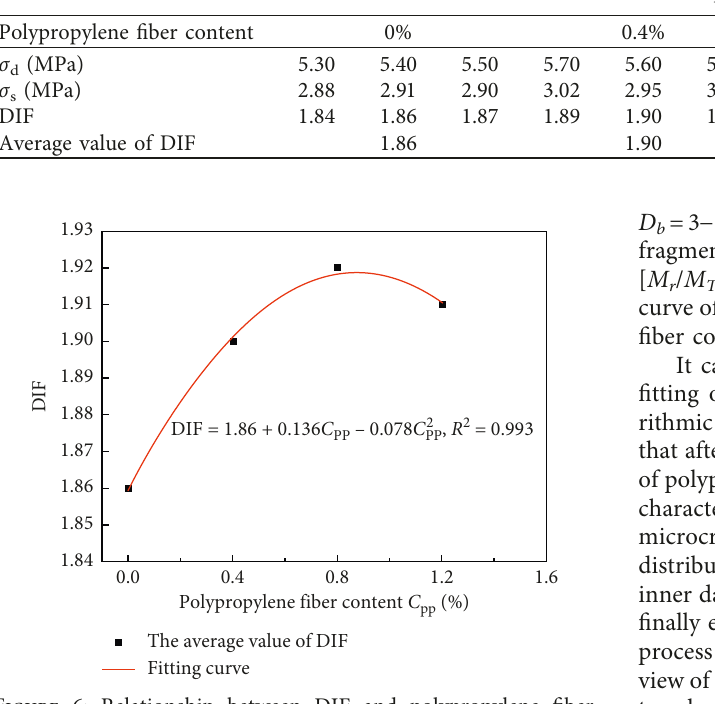
Figure 6: Relationship between DIF and polypropylene fiber